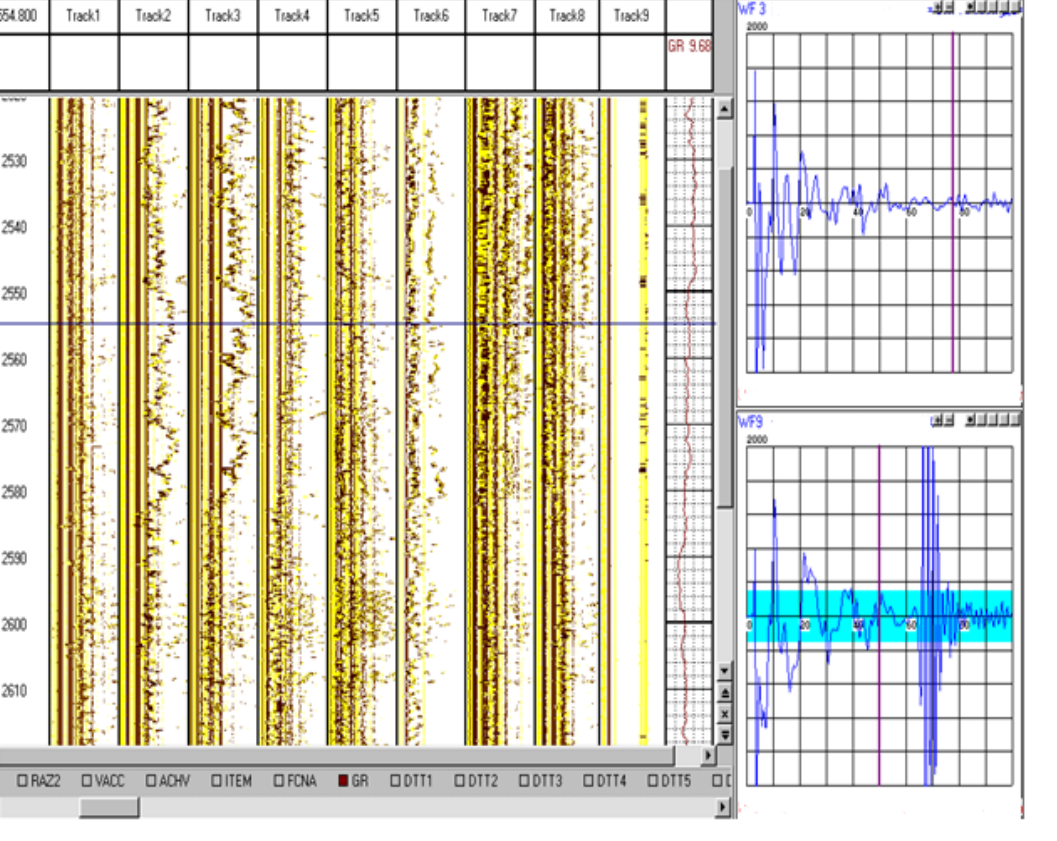
Figure 3. Field Data.